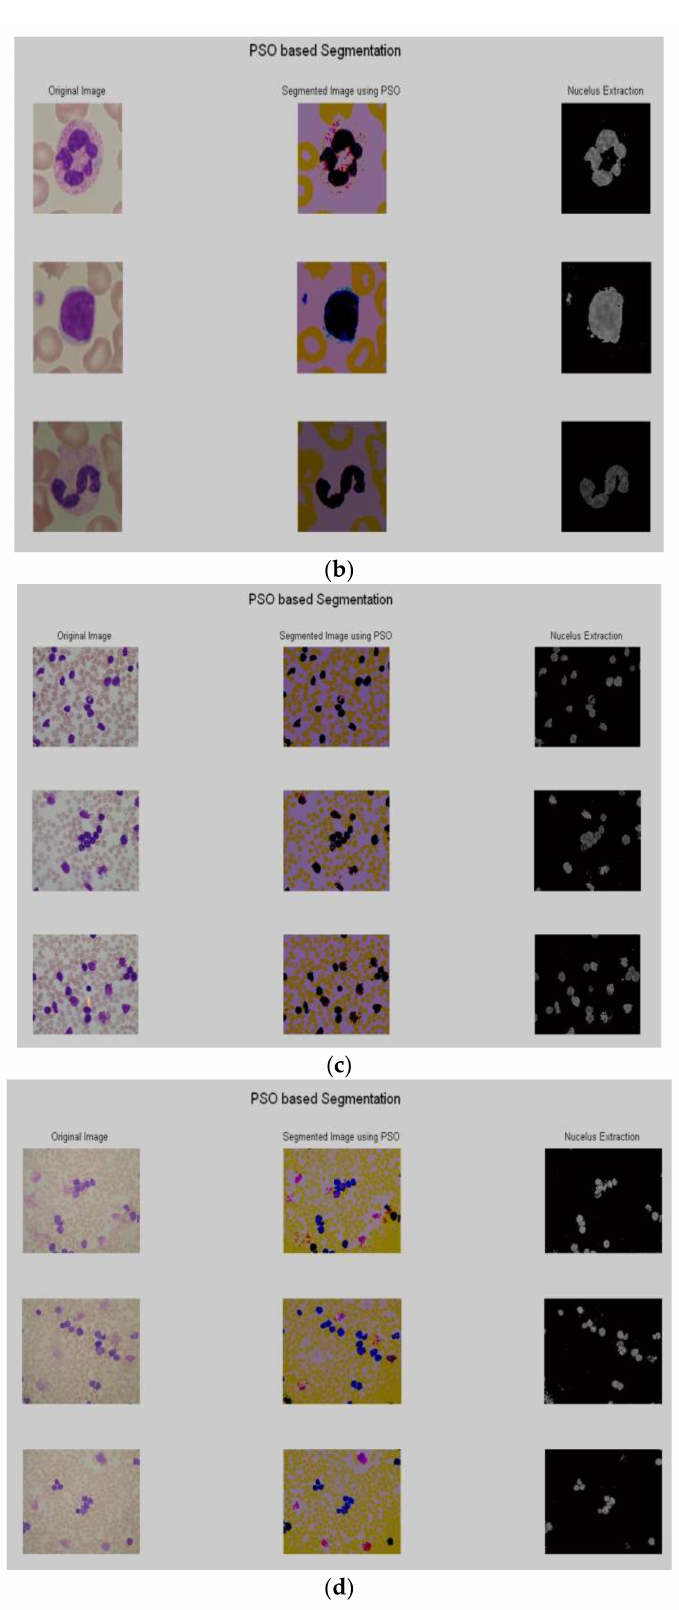
Figure 3. Segmentation results using PSO. as ( a ) Im114_1, Im070_1 and Im073_1; ( b ) Im192_0, Im259_0 and Im248_0; ( c ) Im001_1, Im002_1 and Im018_1; ( d ) Im056_1, Im057_1 and